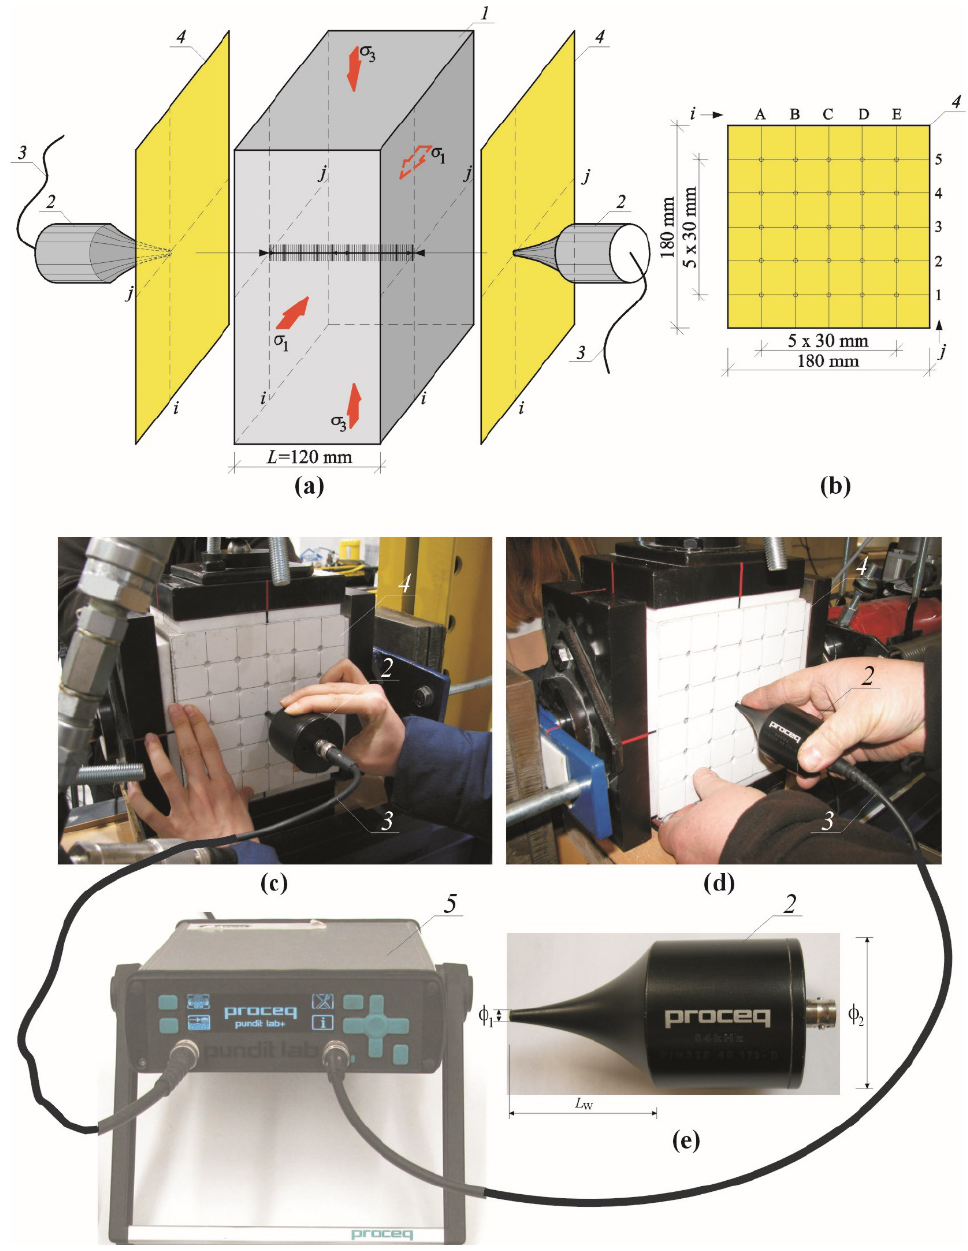
Figure 4. Measurements of ultrasonic wave velocity in biaxially compressed specimens: ( a ) com- ponents of stress states and the position of the measuring template; ( b ) geometry of the measuring template; ( c , d ) the test specimen; ( e ) the exponential transducer; 1–the AAC specimen 180 mm × 180 mm × 120 mm, 2 –exponential transducers, 3 –cables connecting transducers with recording equipment, 4 –the measuring template, 5 –PUNDIT LAB+ recording equipment.